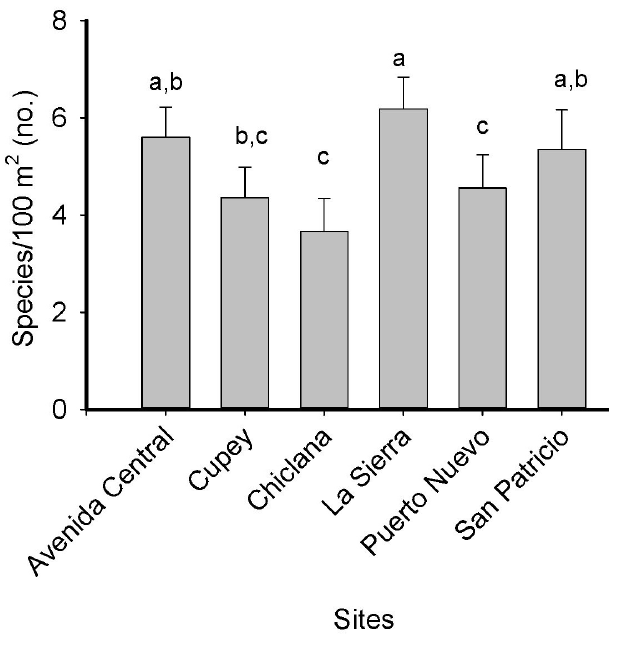
Fig. 3 . Frequency of species per yard across sites within the Rio Piedras watershed. Species density: F5,405 = 1.95, p = 0.09. Different letters indicate significant differences among sites at p < 0.05 using Tukey–Kramer tests.